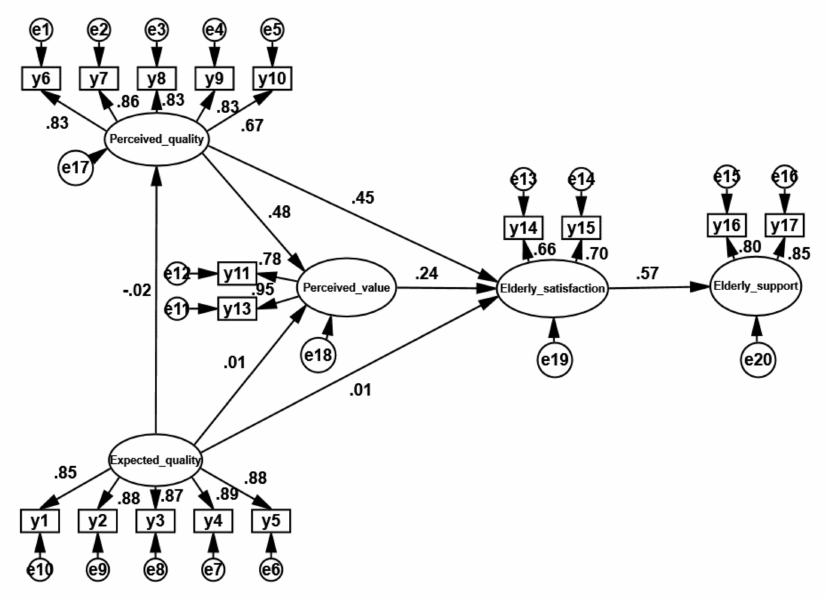
Figure 4. Path coefficients of the nursing service elderly satisfaction model.